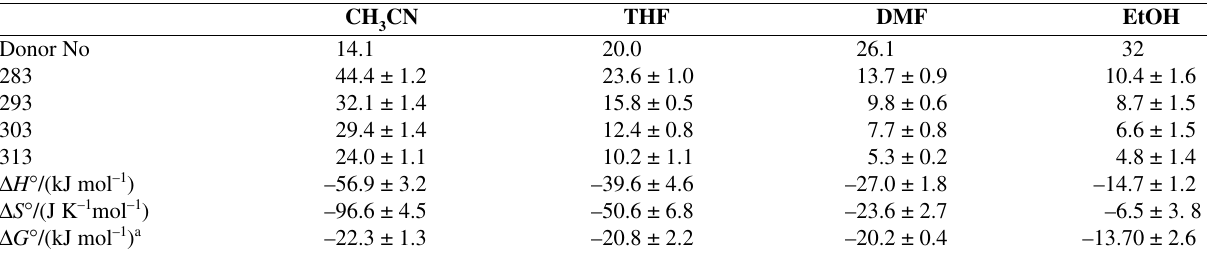
Table 3. The formation constants, (10 –2 × K with Im in different solvents at different temperature (K).